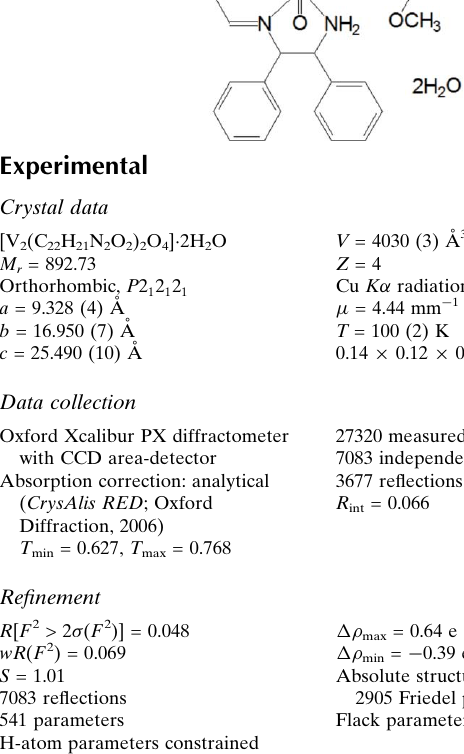
Data collection Oxford Xcalibur PX diffractometer with CCD area-detector Absorption correction: analytical ( CrysAlis RED ; Oxford